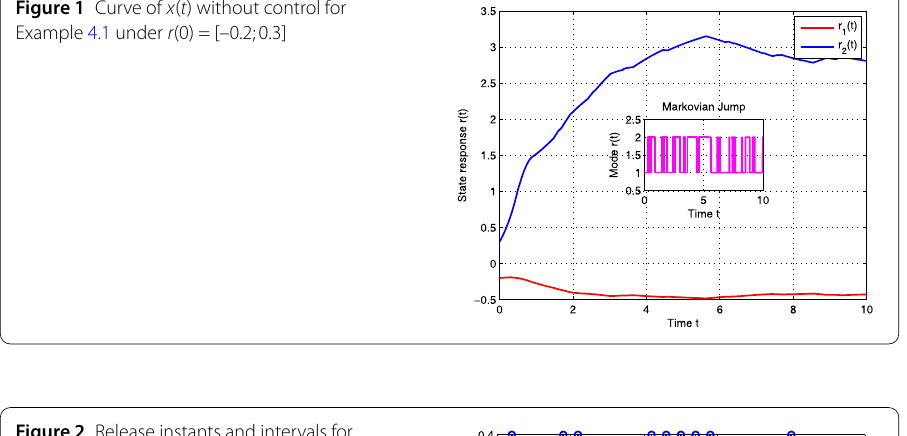
Figure 2 Release instants and intervals for Example 4.1 under r (0) =